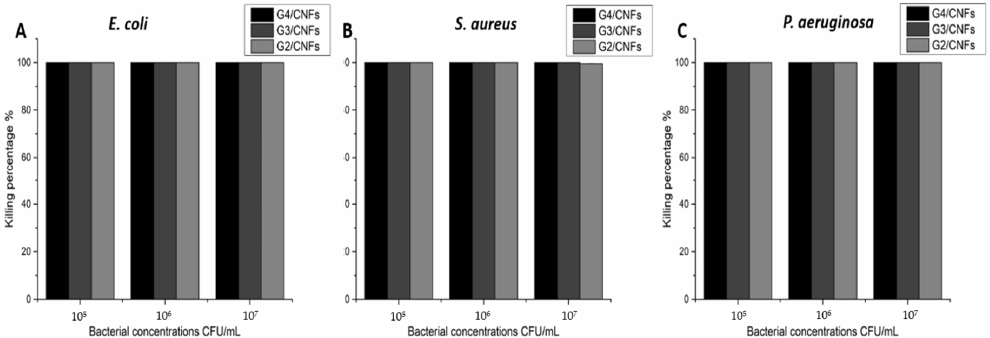
Figure 5. Killing e ffi ciency of the hybrid hydrogels towards di ff erent concentrations of ( A ) E. coli , Figure 5. Killing efficiency of the hybrid hydrogels towards different concentrations of ( A ) E. coli , ( B ) ( B ) S. aureus , ( C ) P. aeruginosa after the incubation for 8 S. aureus , ( C ) P. aeruginosa after the incubation for 8 h.